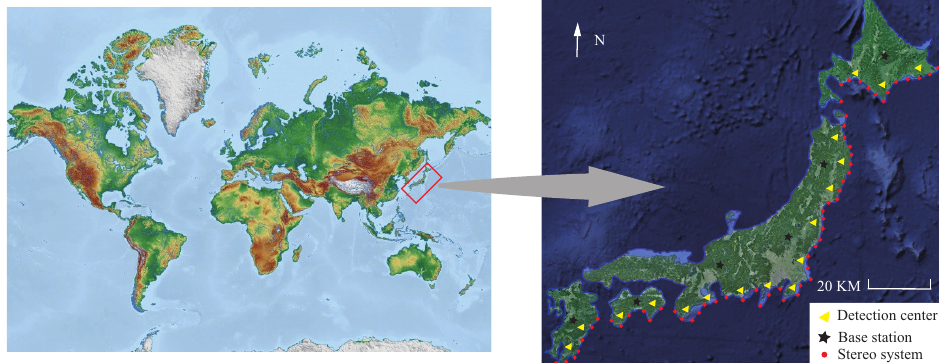
Figure 2. Deployment of the proposed system.